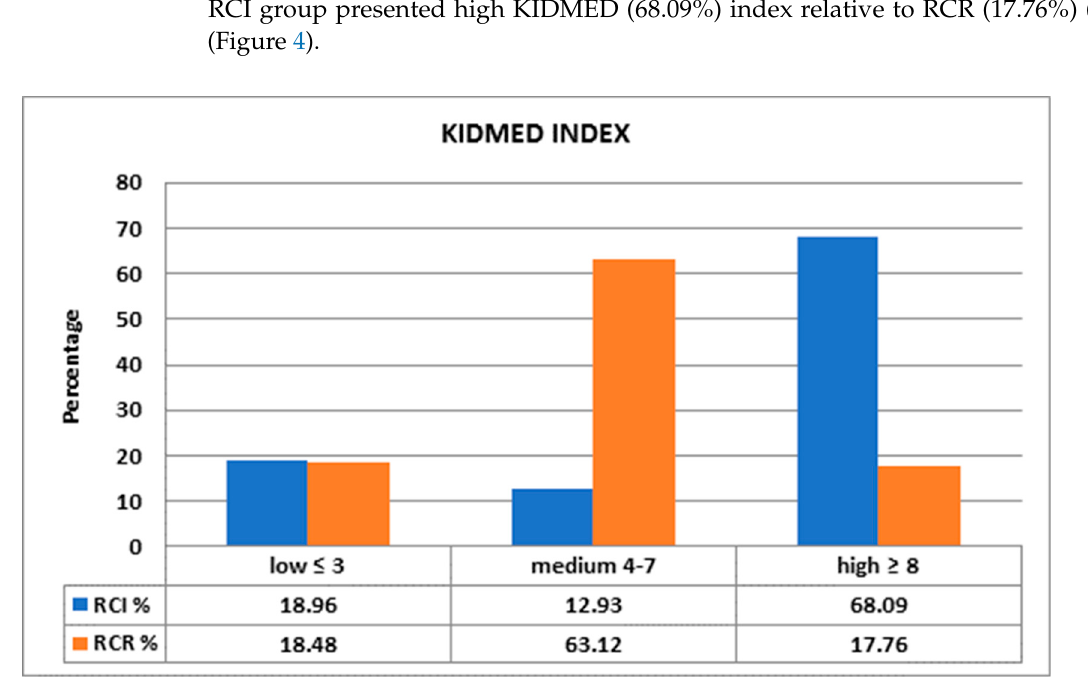
Figure 4. Comparison between KIDMED indexes.